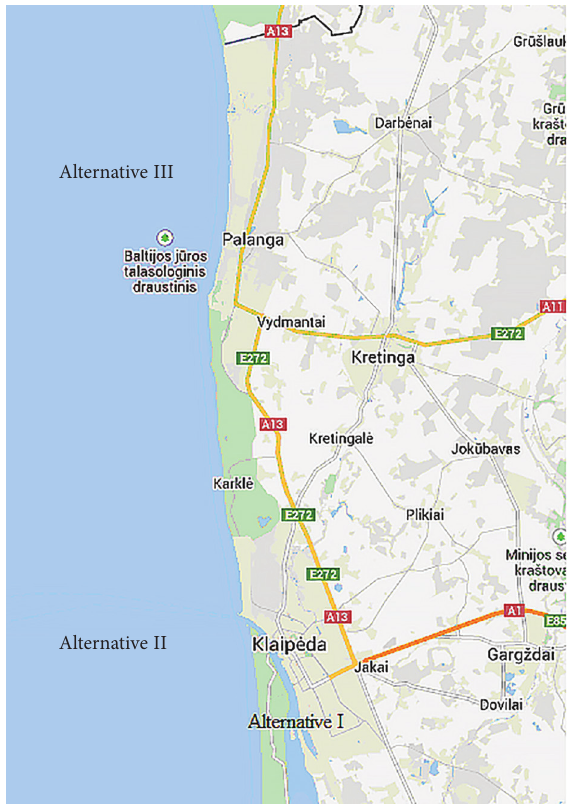
Fig. 2. Potential locations for the LNG